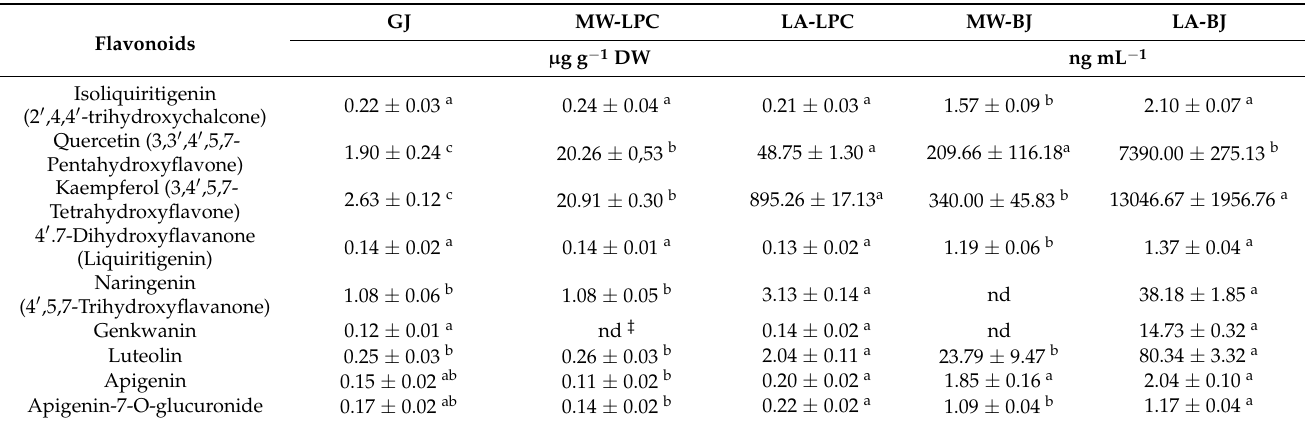
Table 4. Quantitative changes of flavonoids in broccoli green leaves-originated products by different processes ( Process 1; Process2 and Process 3 ): freeze-dried green juice (GJ); leaf protein concentrate obtained by microwave coagulation (MW-LPC); leaf protein concentrate obtained by lactic acid fermentation (LA-LPC); brown juice obtained by microwave coagulation (MW-BJ); and brown juice obtained by lacto-fermentation